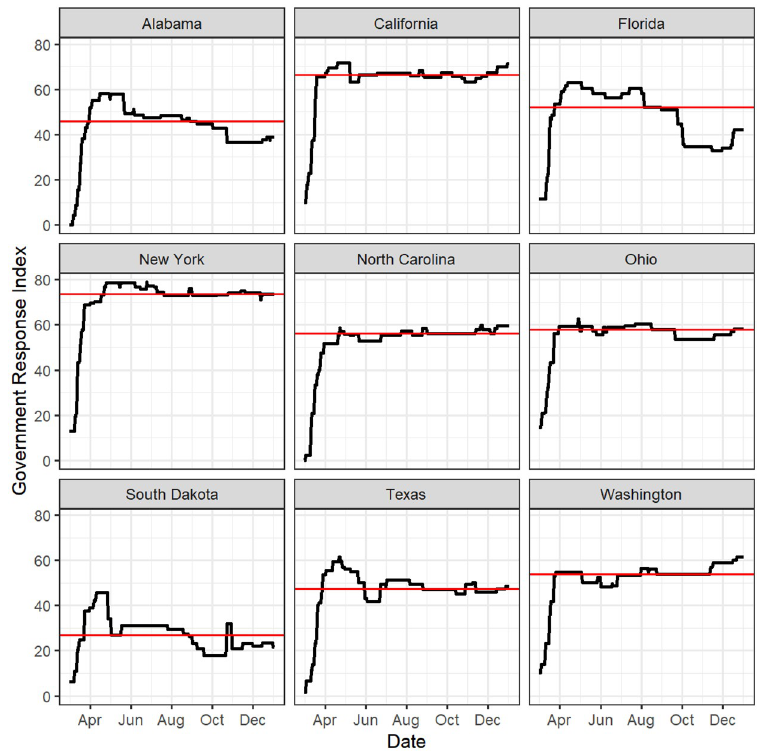
Fig 3. The Blavatnik School of Government’s Government Response Index for nine representative states. The median index is shown in red.